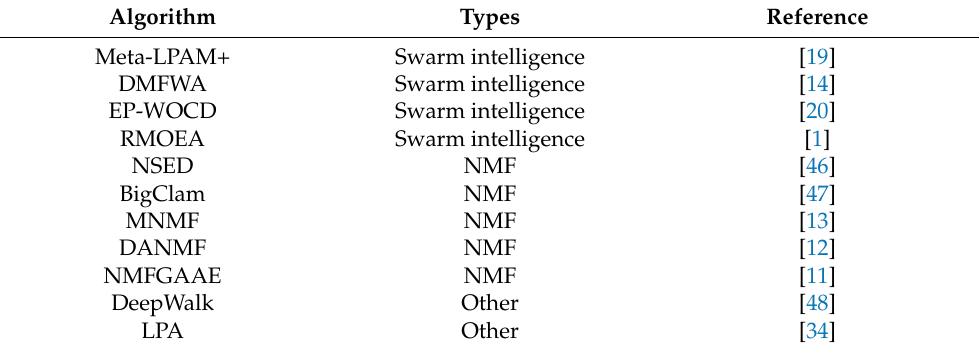
Table 3. The details of 11 algorithms.